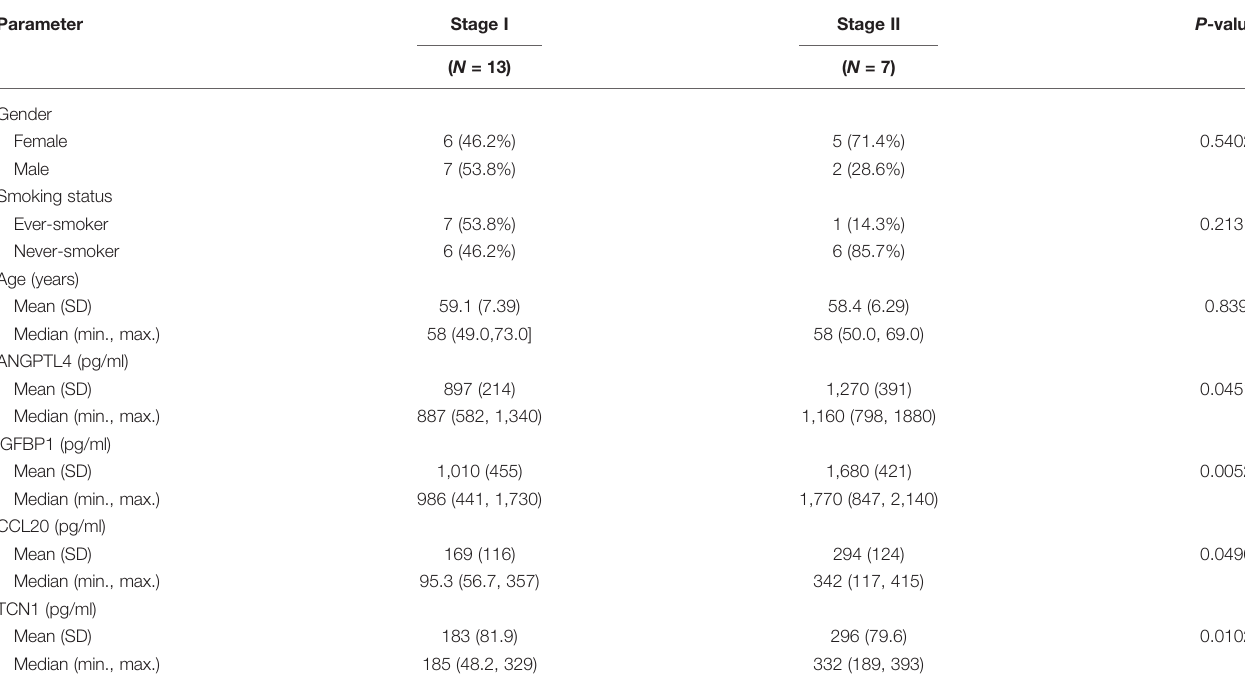
TABLE 2 | Correlation between the plasma levels of the secreted proteins and the clinical stage. Parameter Stage I Stage II P